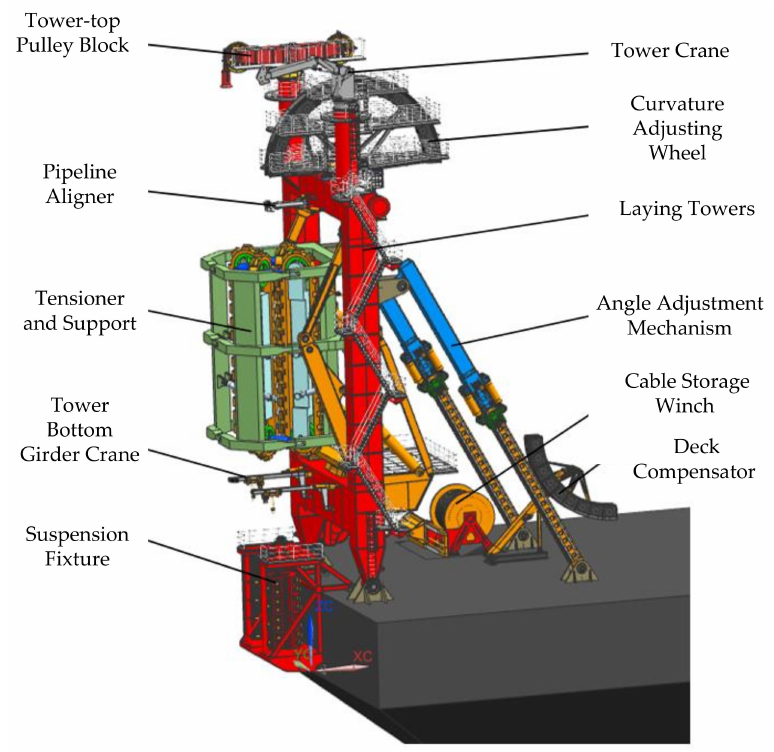
Figure 1. Overall structural diagram of the flexible pipeline-laying